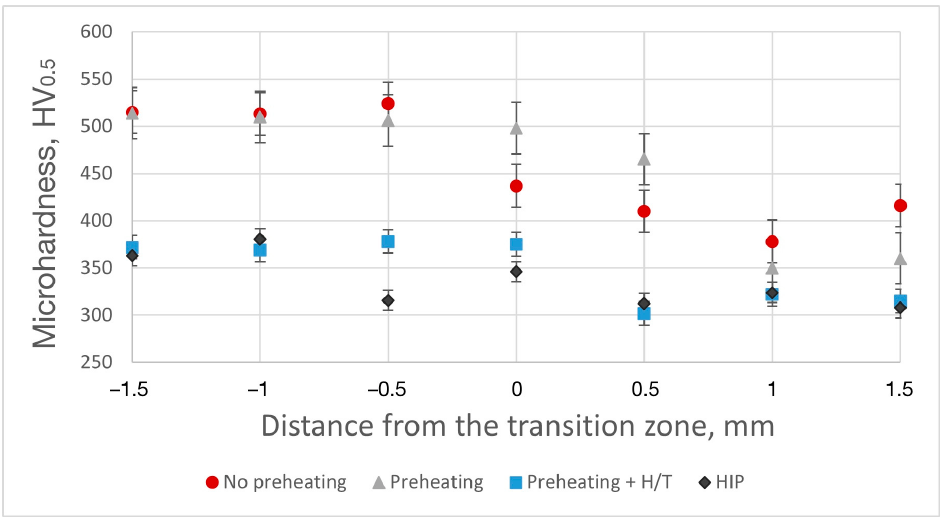
Figure 8. Variation of microhardness along the transition zone of as-fabricated, annealed, and HIPed bimetallic structures.